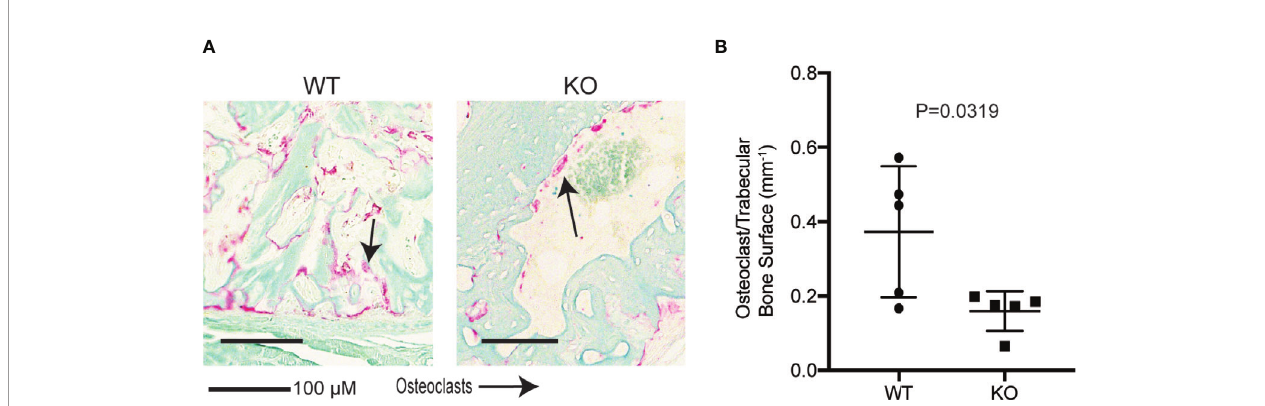
FIGURE 7 | HematopoieticWnt depletion results indecreased osteoclasts in the fracture callus. (A) Representative histology (Tartrate resistant acid phosphatase staining) offracture callus at 3 weeksshowed fewer osteoclasts inthe KOmice. (B) Osteoclast/trabecular bone surface of 3-week-old fractures were decreasedin the